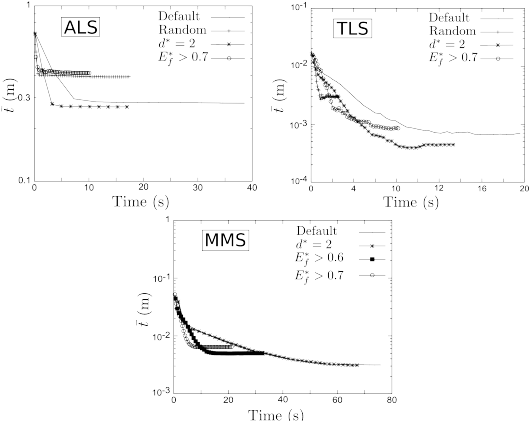
Figure 5: Results of the Selection